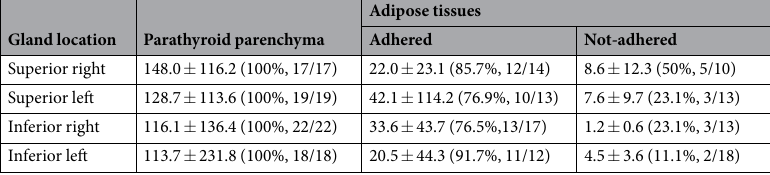
of immunodeficient nude rats (Fig. 3). One to three-and-half months after transplantation, transplants were recovered from rats, and analyzed for the expression of adipocyte markers. Human cells were identified using anti-human cytoplasm antibody. Prior to transplantation, the parenchyma of 12 PTGs were examined for the expression of two adipose markers, PPAR γ 2 or perilipin A. Neither marker was expressed in all specimens, except for one that expressed perilipin A (Table 3). However, when recovered one to three-and-half months after trans- plantation, all eight transplants from three SHPT patients expressed PPAR γ 2 (Fig. 4) and perilipin A (Fig. 5)